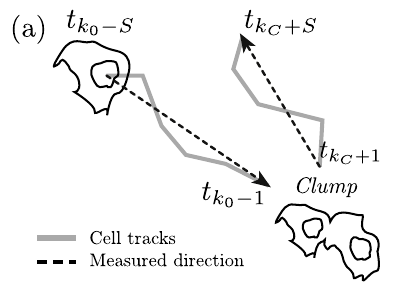
and S frames after t k . The time C 0